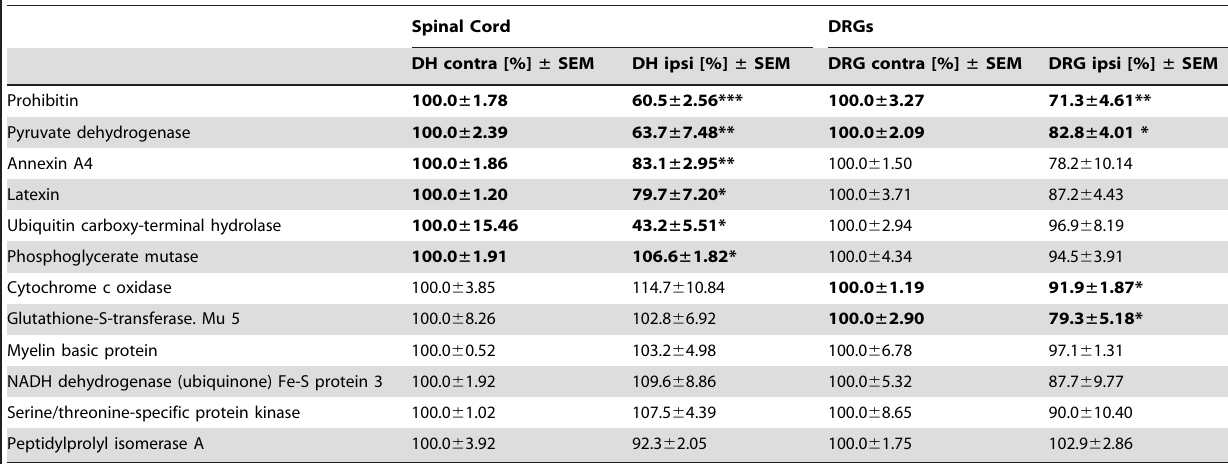
Table 2. mRNA expression in the spinal cord and the